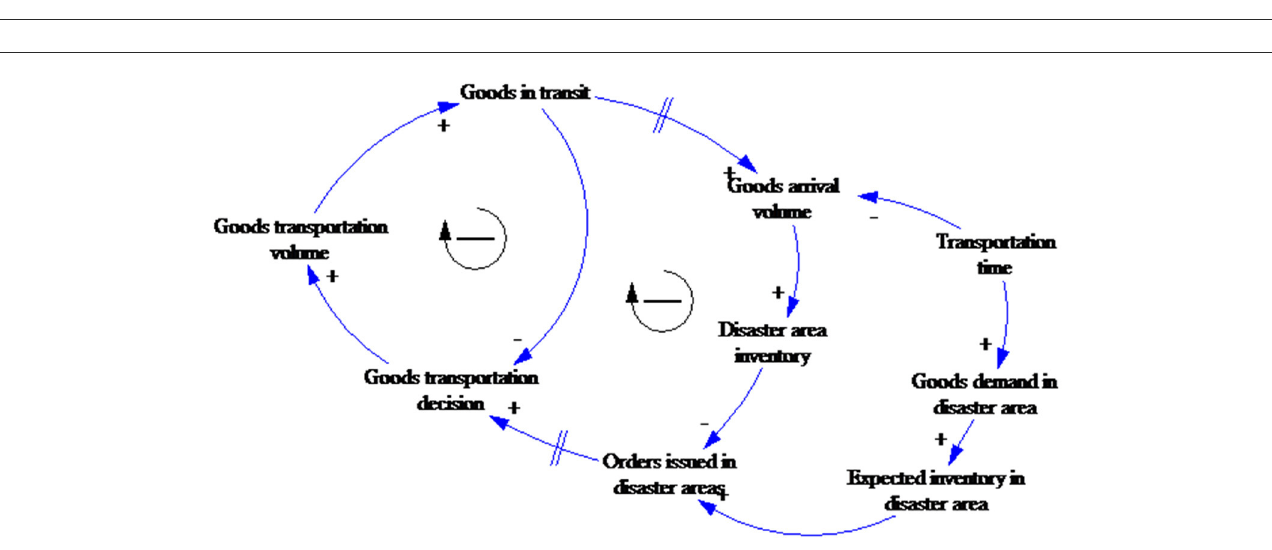
FIGURE4 Relief goods supply system casual loop